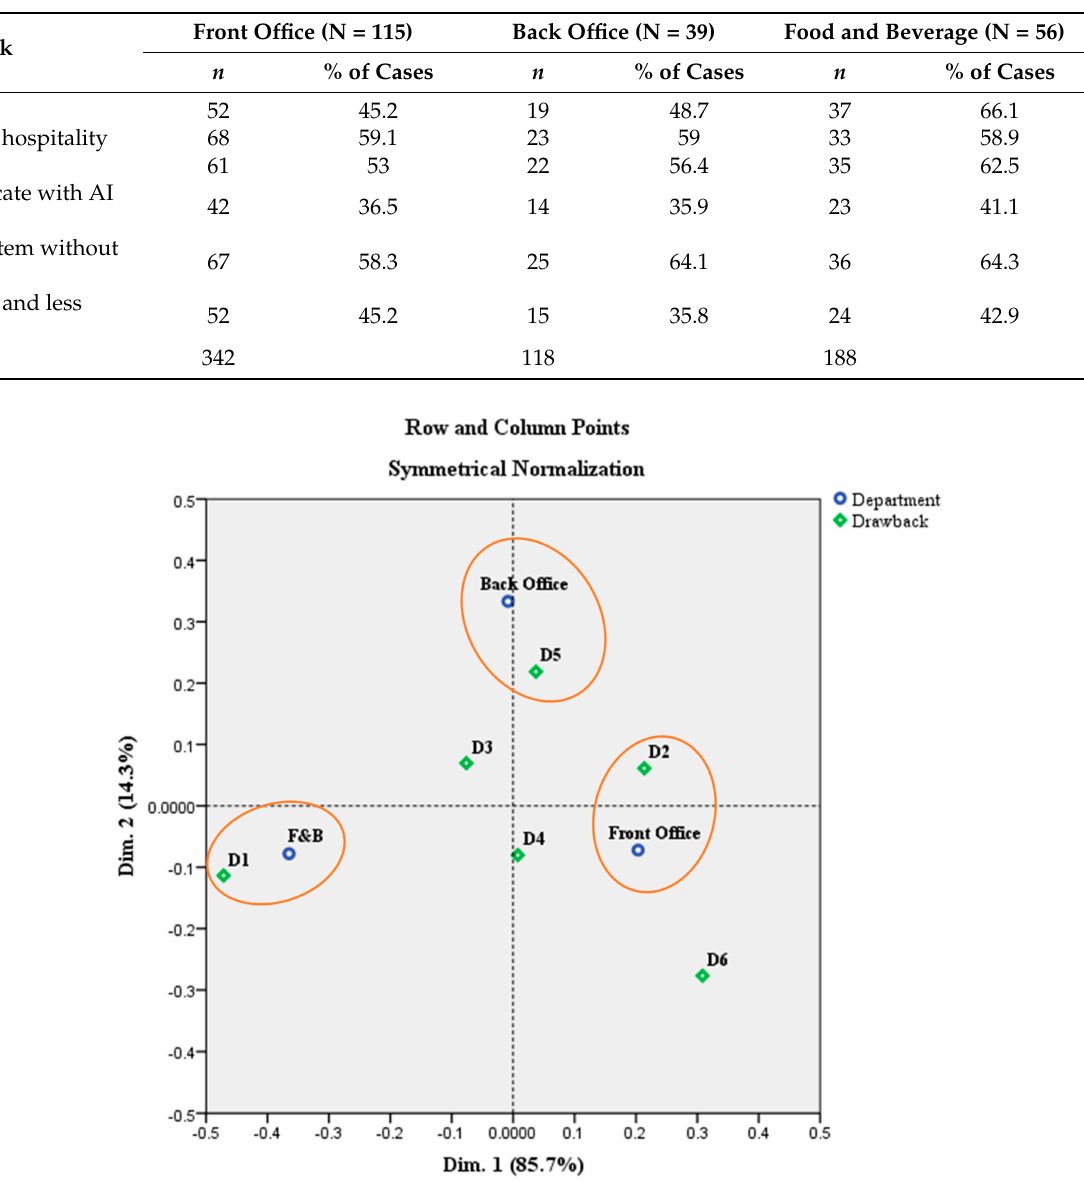
Table 7. Perceived drawbacks of Generation Z hotel employees by departments.